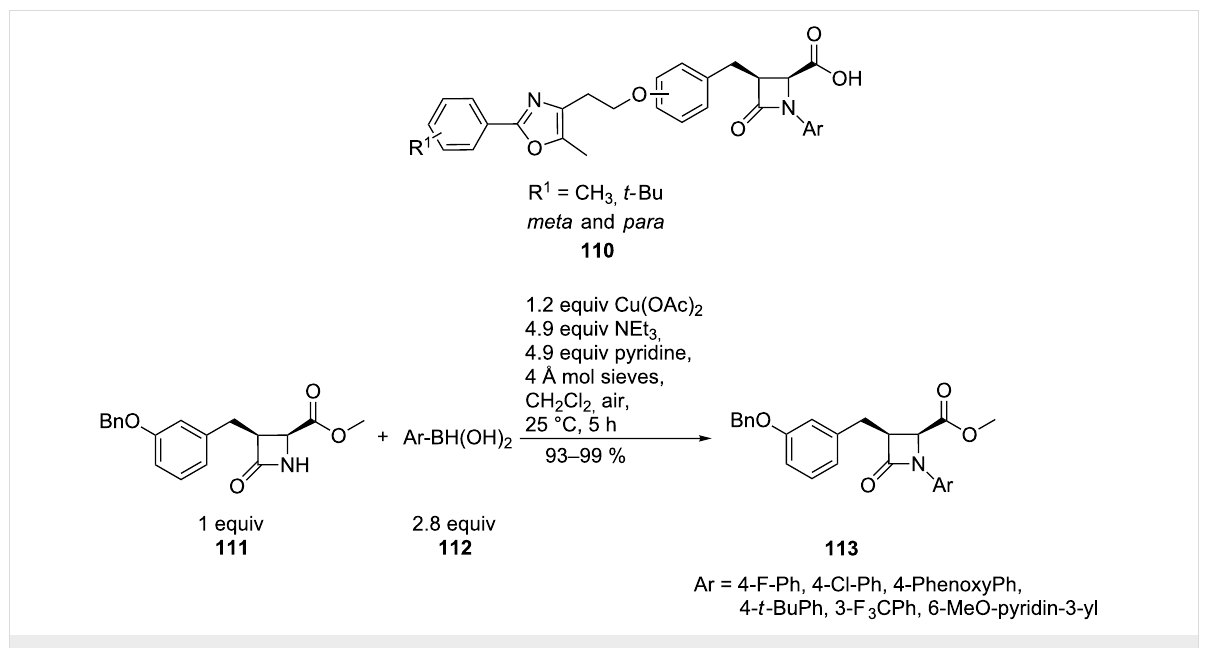
Scheme 26: Synthesis of dual PPAR α / γ agonists.